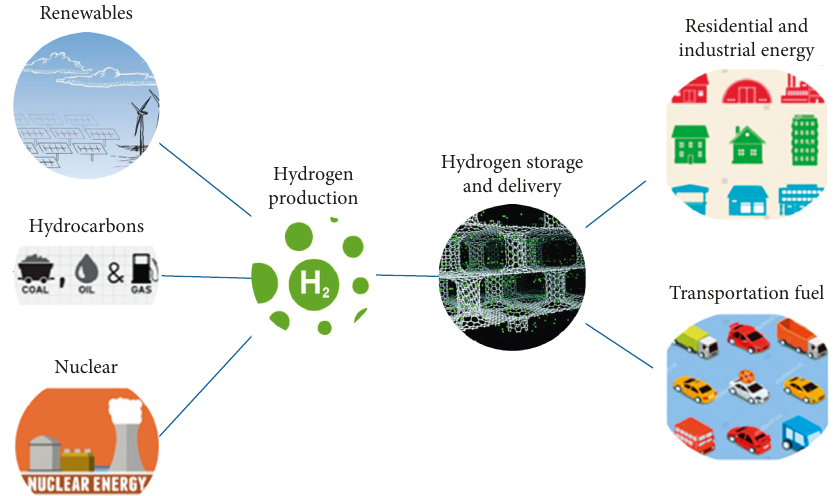
Figure 13: Schematic representing a hydrogen energy system. About 95% of the hydrogen currently produced across the world comes from nonrenewable